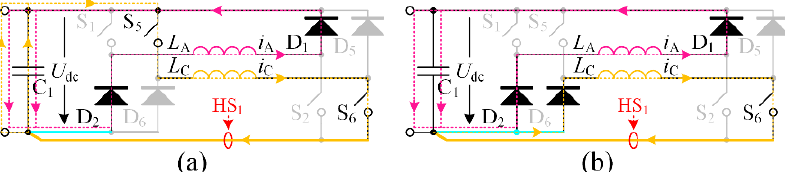
Figure 5. Possible current paths through bus I in the expected conduction region of phase C. ( a ) Phase C in excitation mode. ( b ) Phase C in freewheeling mode I.